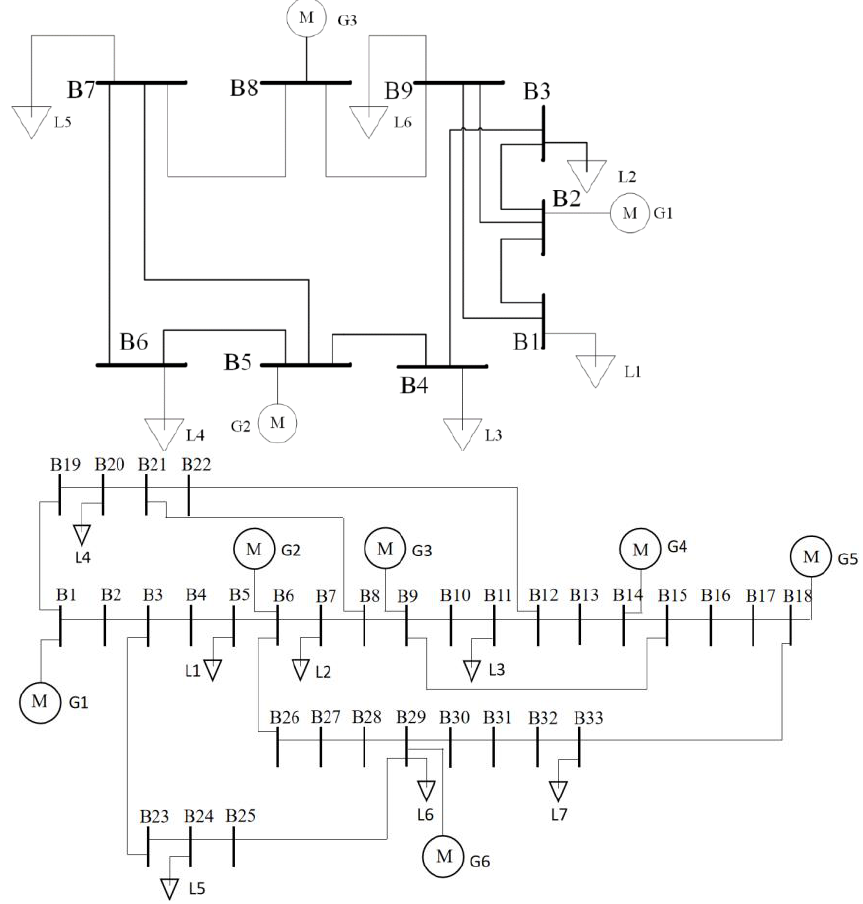
Figure 4. The 9-bus system and the 33-bus system used in the numerical study. (B stands for bus, L stands for load, and G stands for generator)